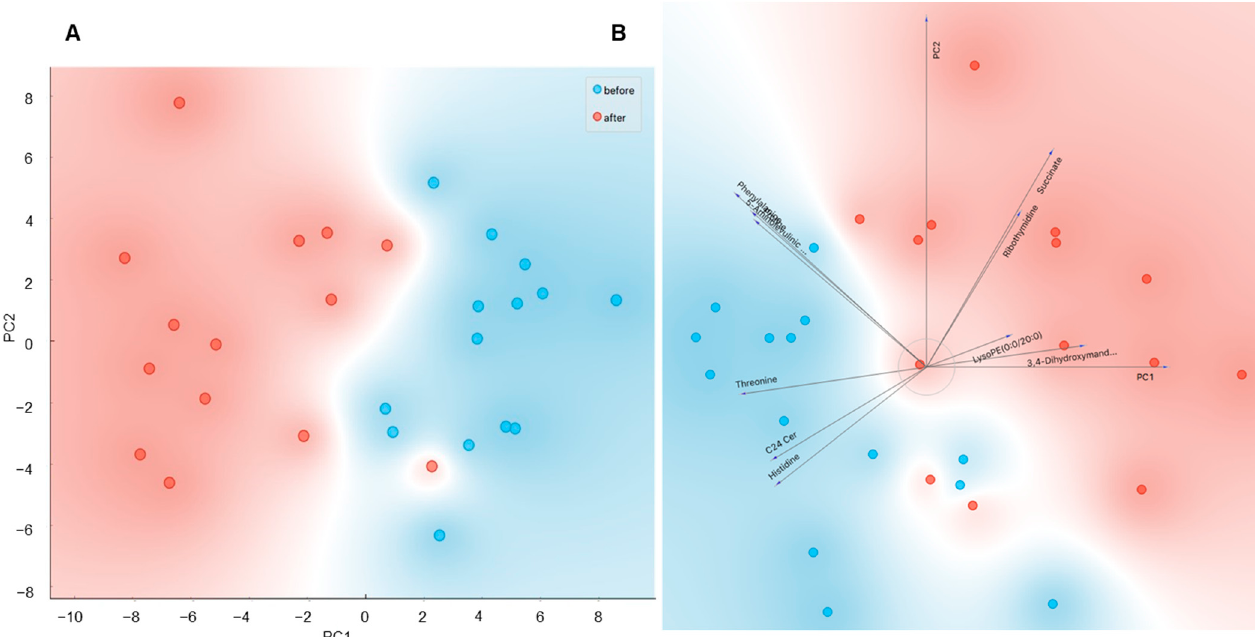
Figure 1. The principal component analysis (PCA) of plasma metabolome before and after ice-water swimming, explaining 50.1% of variance, PC2 = 15.4%, showing ( A ) score plot of the PCA from all 70 significantly regulated metabolites and ( B ) loading plot (biplot) of the first 10 most significantly changed metabolites. The effect of ice-water swimming was analyzed using Wilcoxon matched pairs signed-rank test with Benjamini–Hochberg correction for multiple comparison. Blue — before, red—after ice-water swimming.